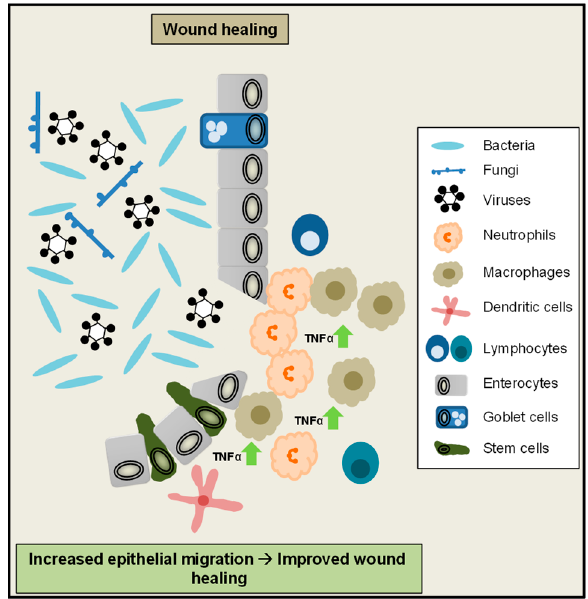
Figure 3. TNF α regulates intestinal cell survival and wound healing. Increased TNF α levels in the gut might drive epithelial cell survival and proliferation, leading to improved wound healing and mucosal repair after injury or during chronic